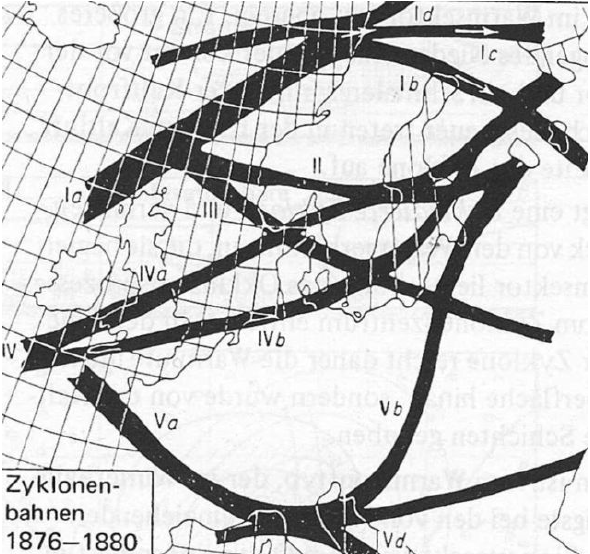
Figure 1 : Storm tracks according to van Bebber (1891). Figure 1. Storm tracks according to van Bebber